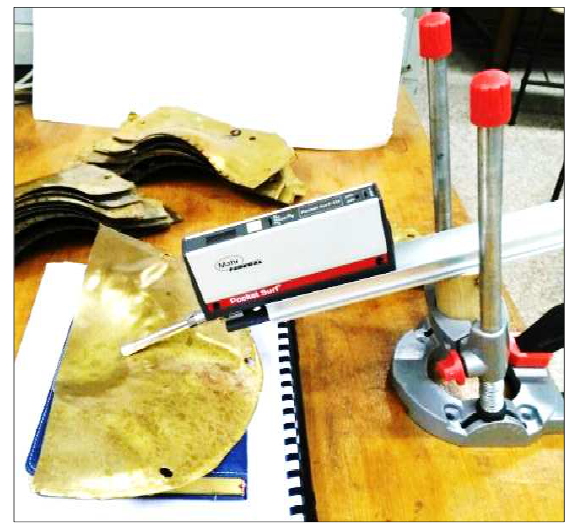
Fig. 6. Surface roughness measurement device Surface roughness measurement device.